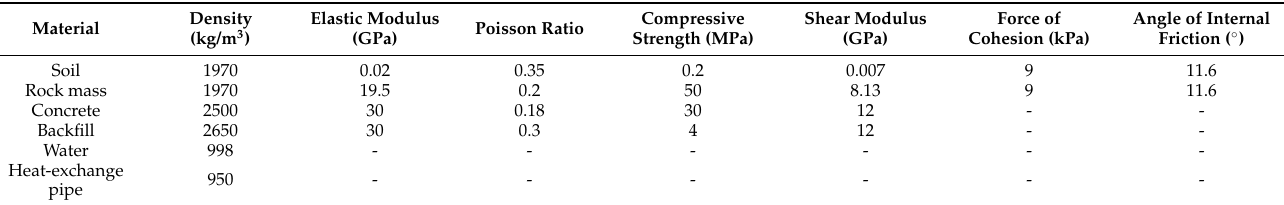
Table 3. Physical and mechanical parameters of each entity unit.